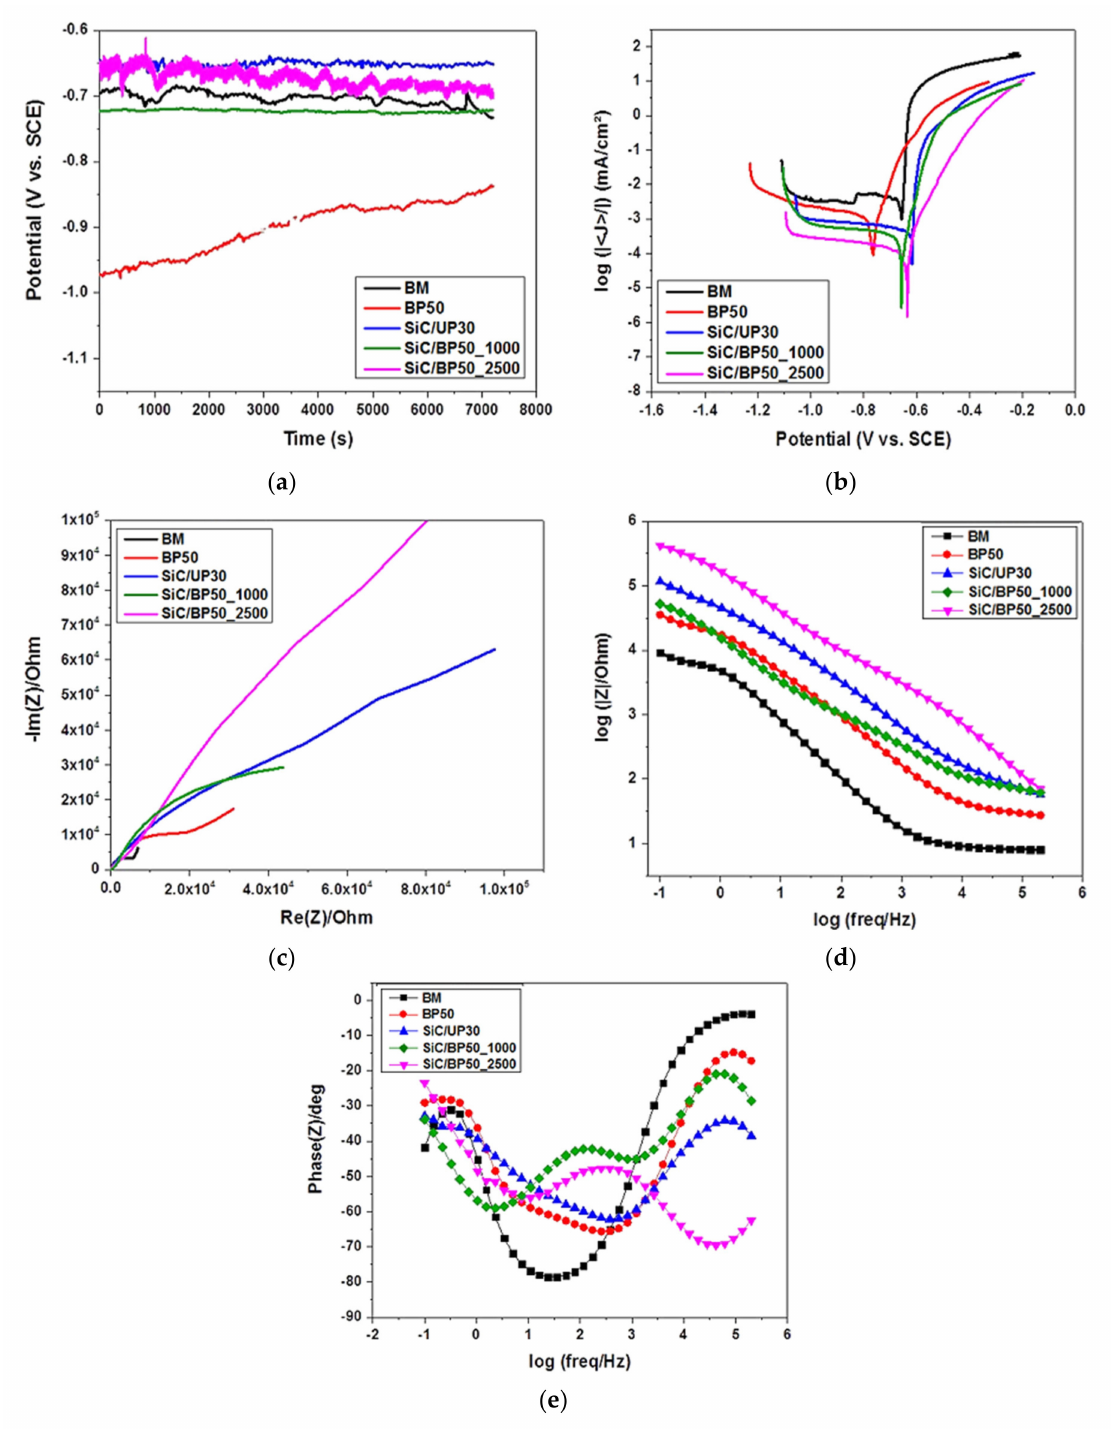
Figure 6. Corrosion measurement curves of PEO-coated AA2014 Al samples: ( a ) open circuit potential, ( b ) potentiodynamic polarization curves, ( c ) Nyquist plots, ( d ) electrochemical impedance diagrams (Bode plot), and ( e ) phase